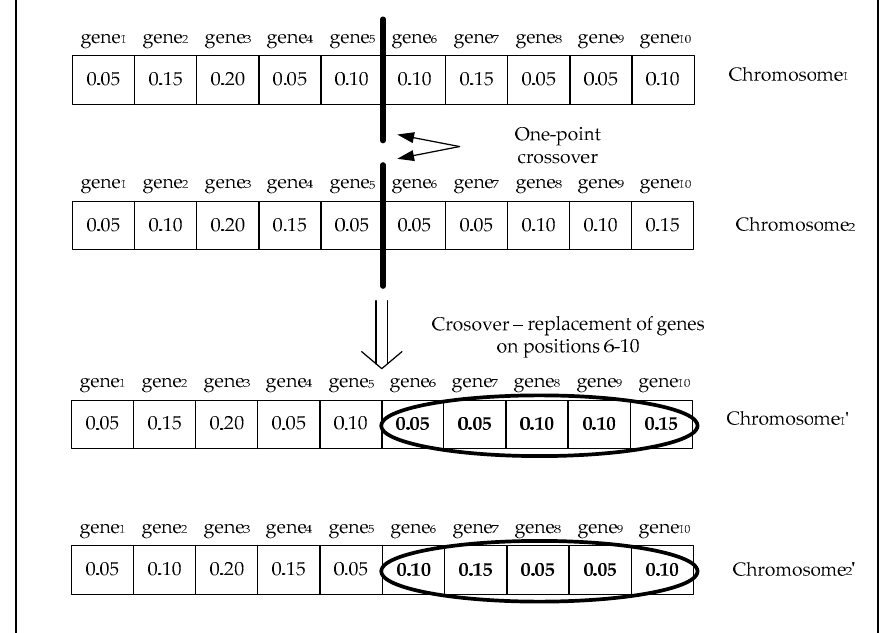
Figure 6. The example of crossover with one crossover point.